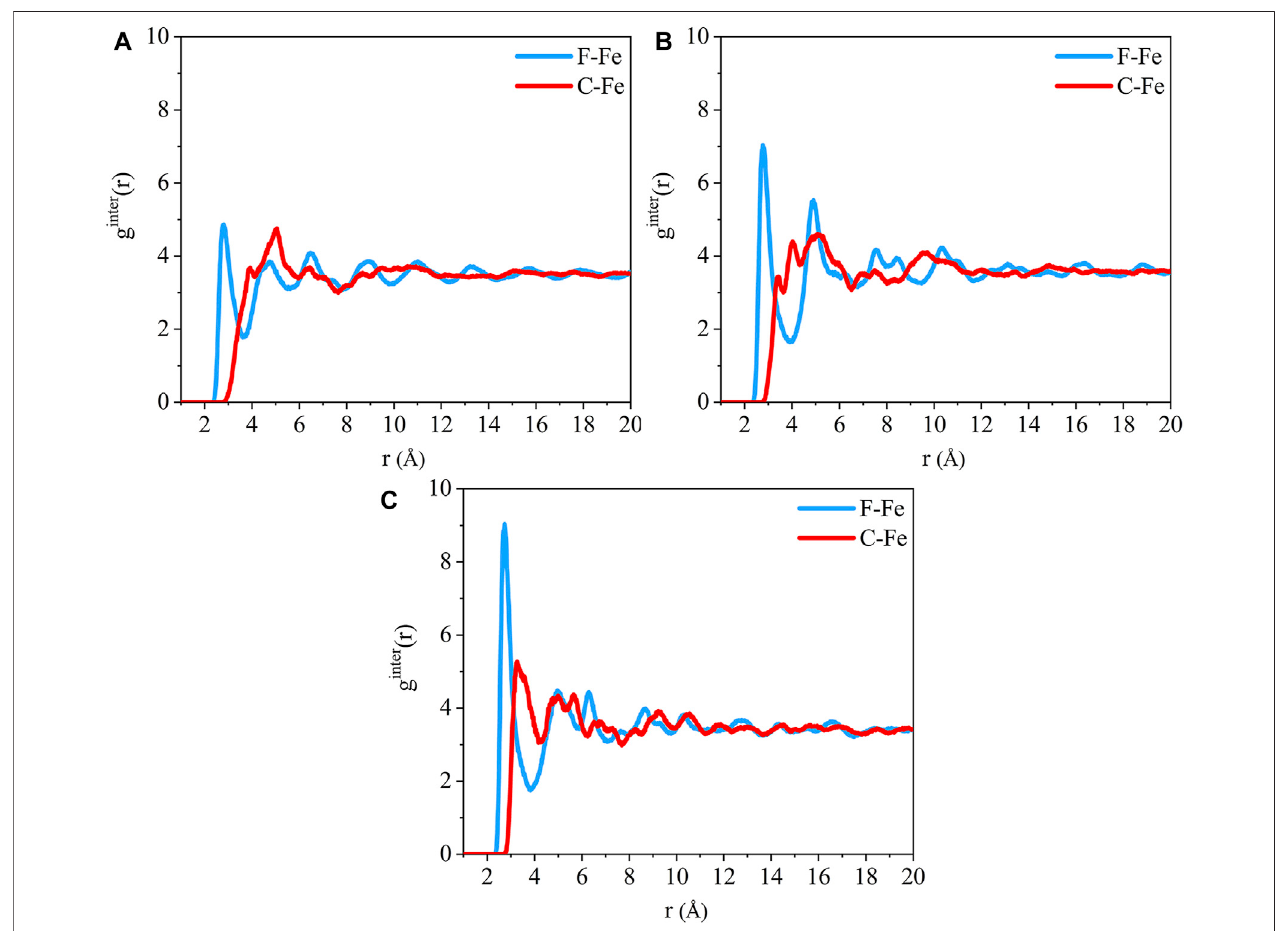
FIGURE 4 | Radial distribution function of the F-Fe and C-Fe pairs for the (A) (110)/PTFE, (B) (100)/PTFE, and (C) (111)/PTFE interface systems.